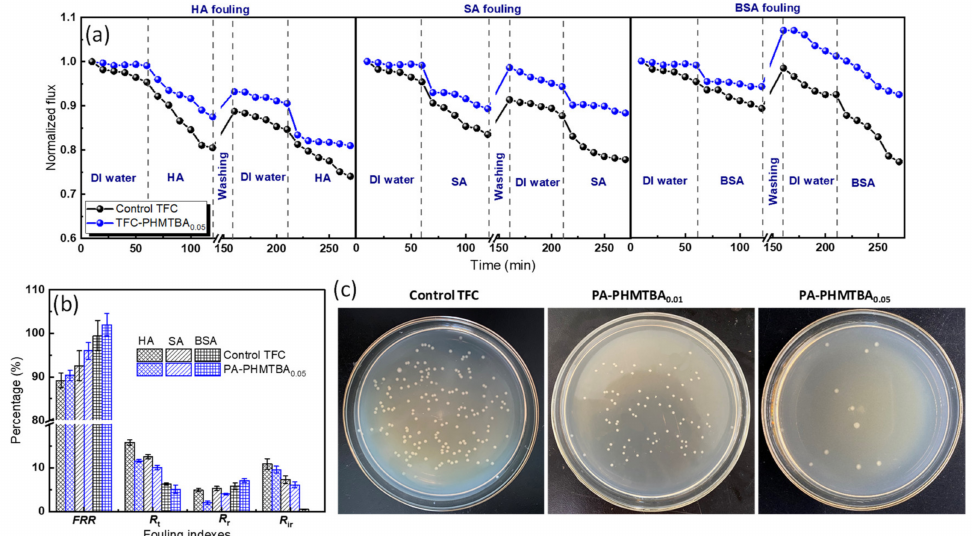
Figure 9. Anti-fouling properties of the as-prepared TFC membrane. ( a ) Normalized fluxes with various pollutants filtration, ( b ) fouling indexes, and ( c ) images of Petri dishes of the unmodified and PHMTBA-modified membranes.